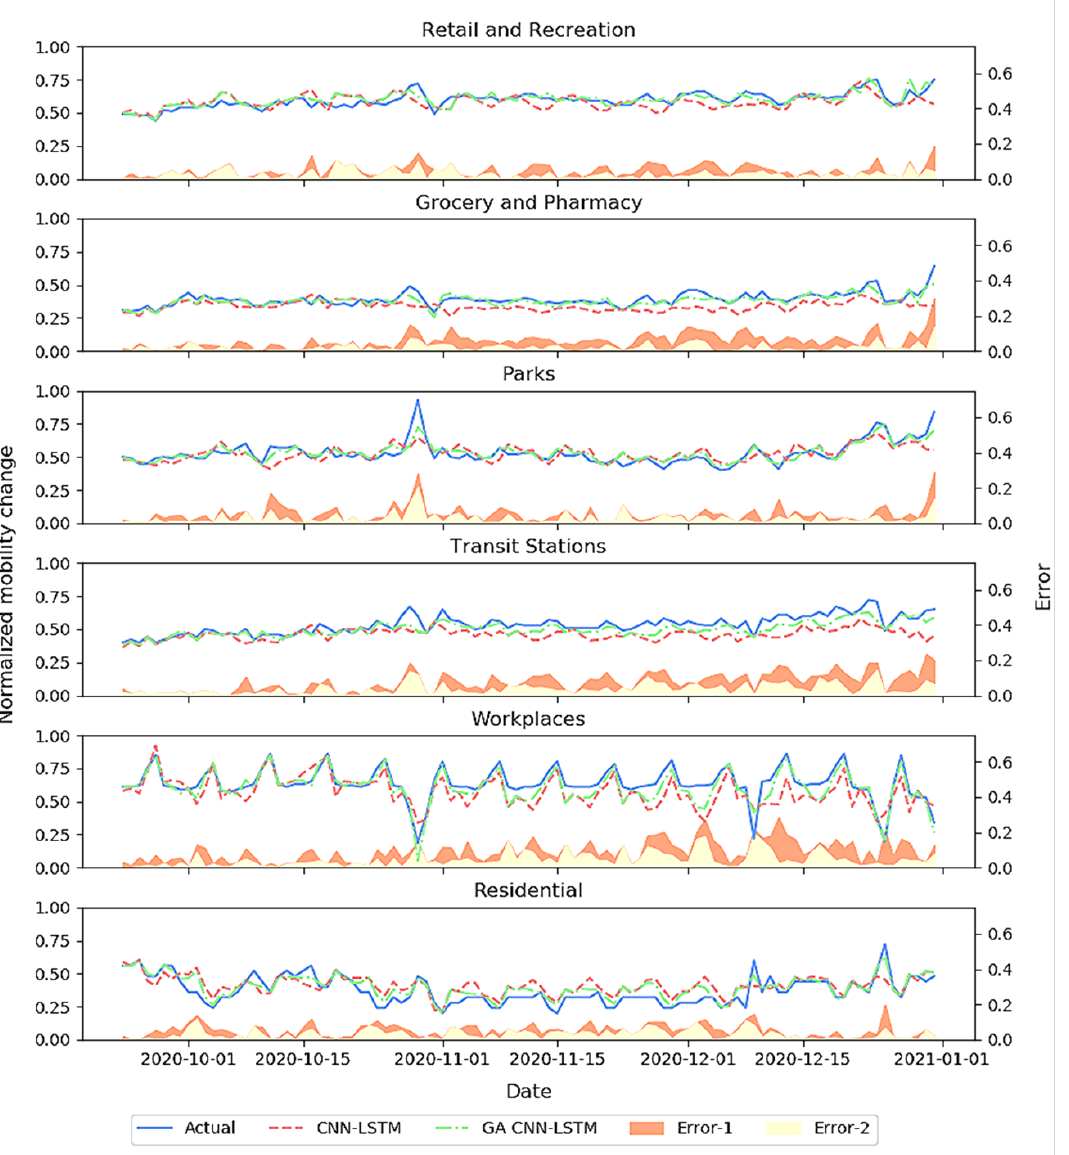
Figure 9. Comparison of actual values and prediction in six mobility area by ensemble of CNN-LSTM and GA CNN-LSTM. The Error-1 represents error in prediction produced by ensemble of CNN-LSTM while Error-2 represents error in prediction produced by GA